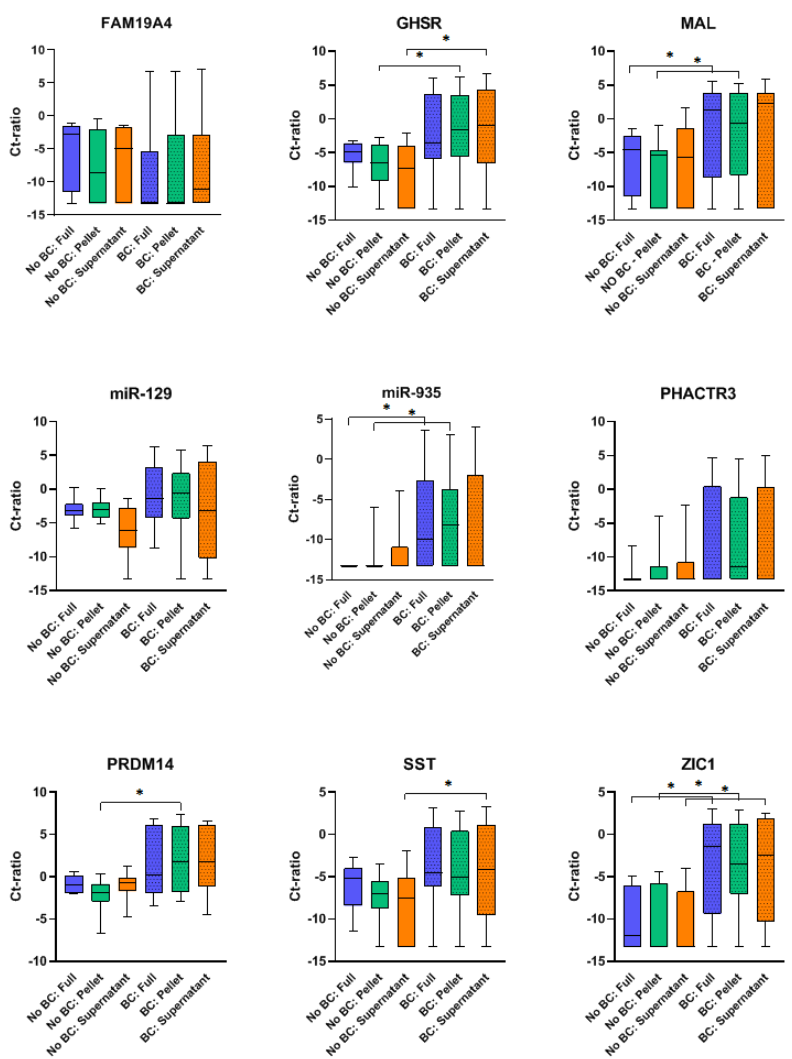
Figure 1. Box plots of methylation levels for bladder cancer (BC) patients and benign hematuria controls in each urine fraction (full void, pellet and supernatant) per methylation marker. Significant outcomes ( p < 0.05) of the Mann–Whitney U test are displayed as *.